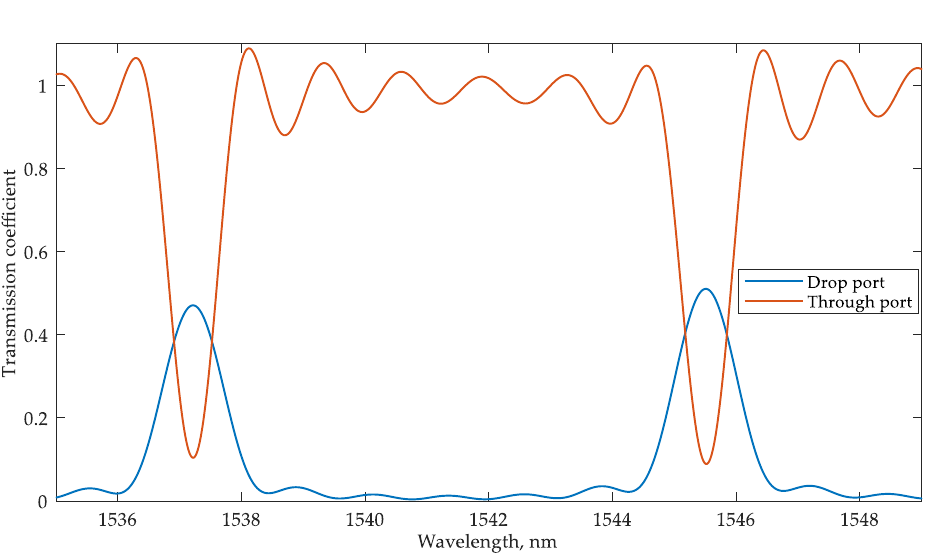
Figure 7. Transmission spectra at the through and drop ports of the interrogator MRR.